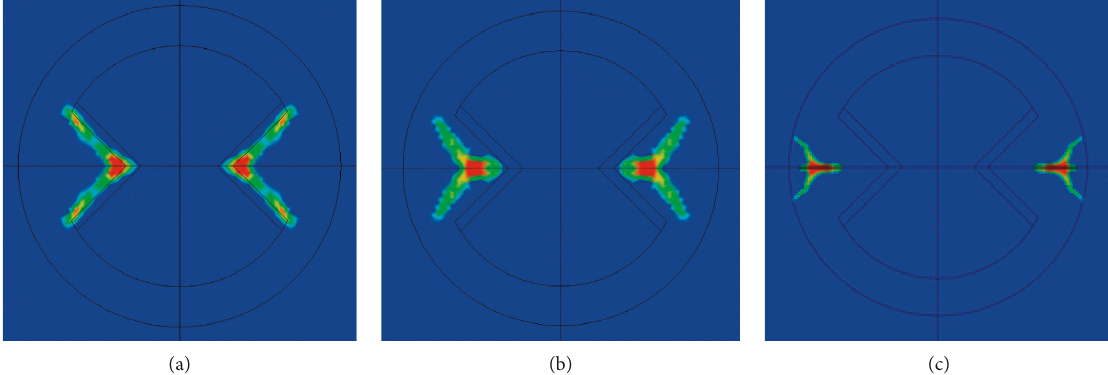
Figure 4: Process of shaped charge jet formation and migration under cumulative blasting with decoupling coefficient 1.33: (a) t � 4.96 μ s;